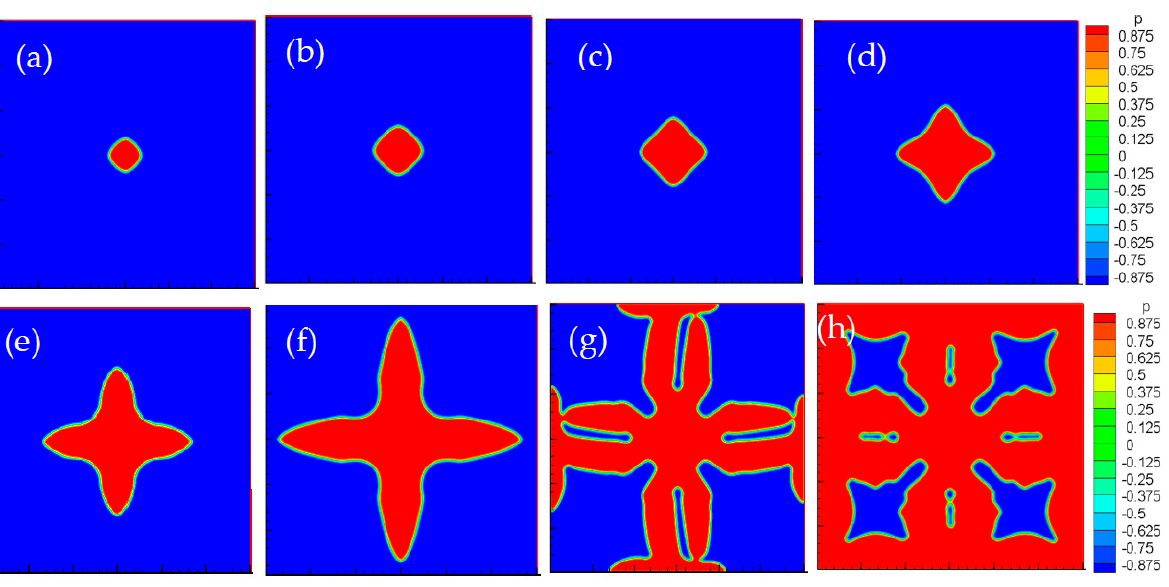
Figure 1. Δ t = 45,000. The undercooling is ( a ) Δ = − 0.15; ( b ) Δ = − 0.25; ( c ) Δ = − 0.35; ( d ) Δ = − 0.45; ( e ) Figure 1. ∆ t = 45,000. The undercooling is ( a ) ∆ = − 0.15; ( b ) ∆ = − 0.25; ( c ) ∆ = − 0.35; ( d ) ∆ = − 0.45; Δ = − 0.55; ( f ) Δ = − 0.65; ( g ) Δ = − 0.75; ( h ) Δ = − 0.85. Crystal phase field morphology. ( e ) ∆ = − 0.55; ( f ) ∆ = − 0.65; ( g ) ∆ = − 0.75; ( h ) ∆ = − 0.85. Crystal phase field